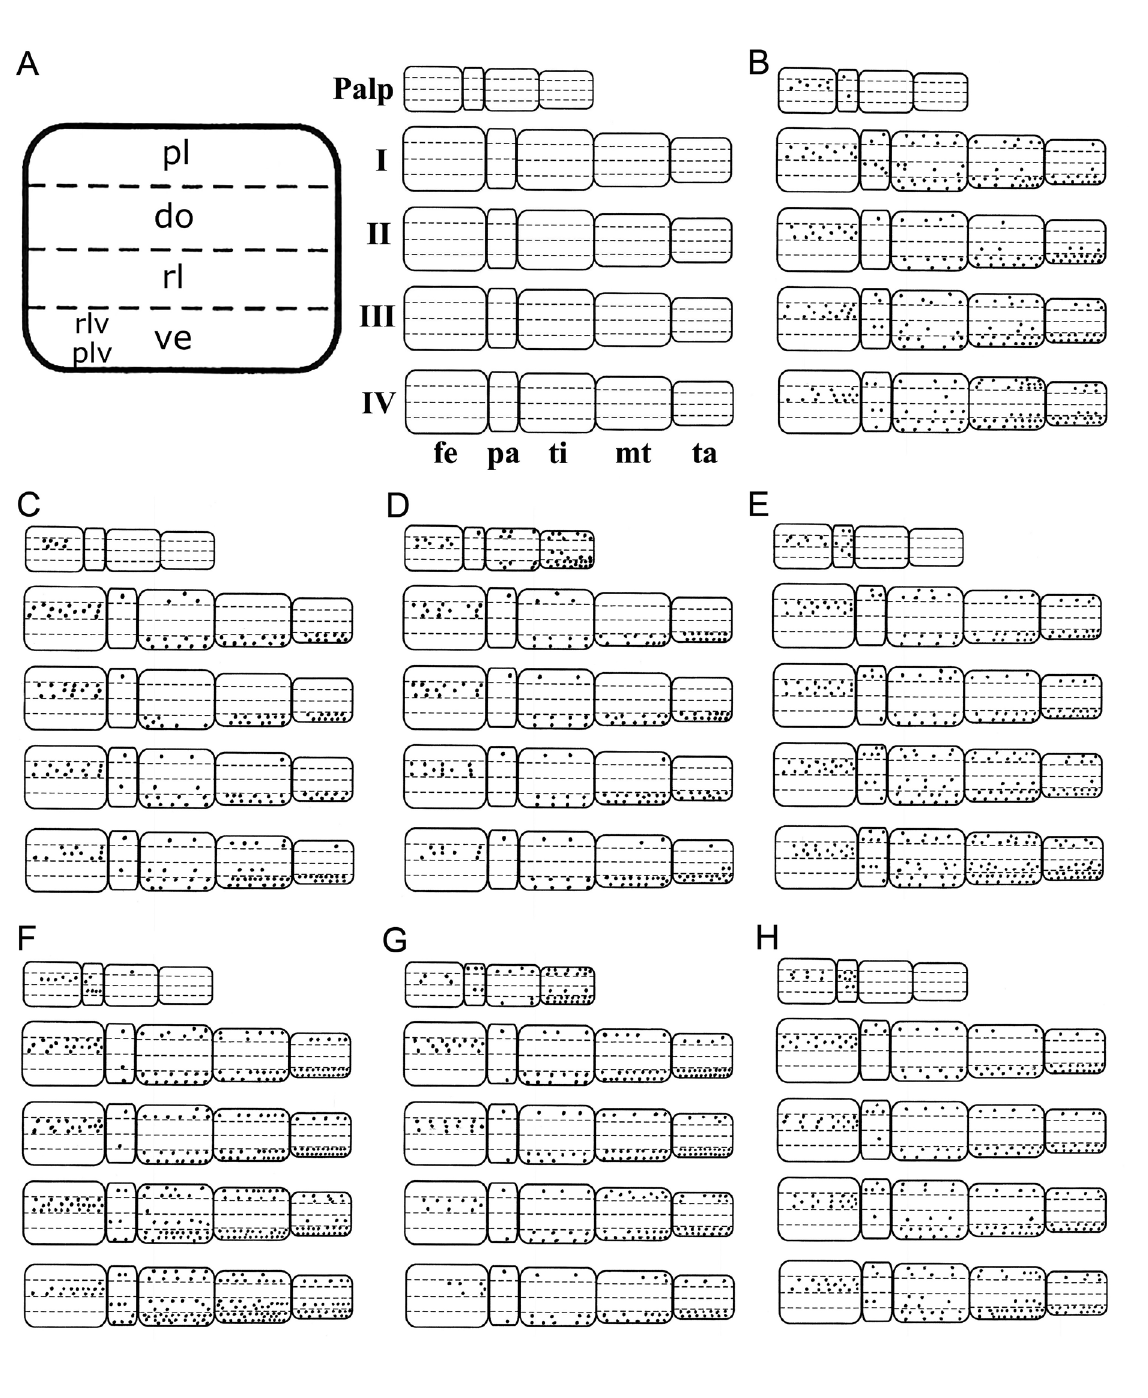
Fig. 4. Leg spination schematics. A . Legend. B . Uroctea hashemitorum Bosselaers, 1999, holotype, ♂ (RBINS). C . Uroctea durandi (Latreille, 1809), ♂ from Spain, Catalonia, Empordà (CJB-3992). D . Uroctea durandi , ♀ from Spain, Catalonia, Empordà (CJB-2198). E . Uroctea thaleri Rheims, Santos & van Harten, 2007, ♂ from Hormozgan Province, Minab County (MHNG). F . Uroctea grossa Roewer, 1960, ♂ from Sistan and Baluchistan Province, surroundings of Taftan volcano (MHNG). G . Uroctea grossa , holotype, ♀ (GNM-A497). H . Uroctea gambronica sp. nov., holotype, ♂ (NMP-